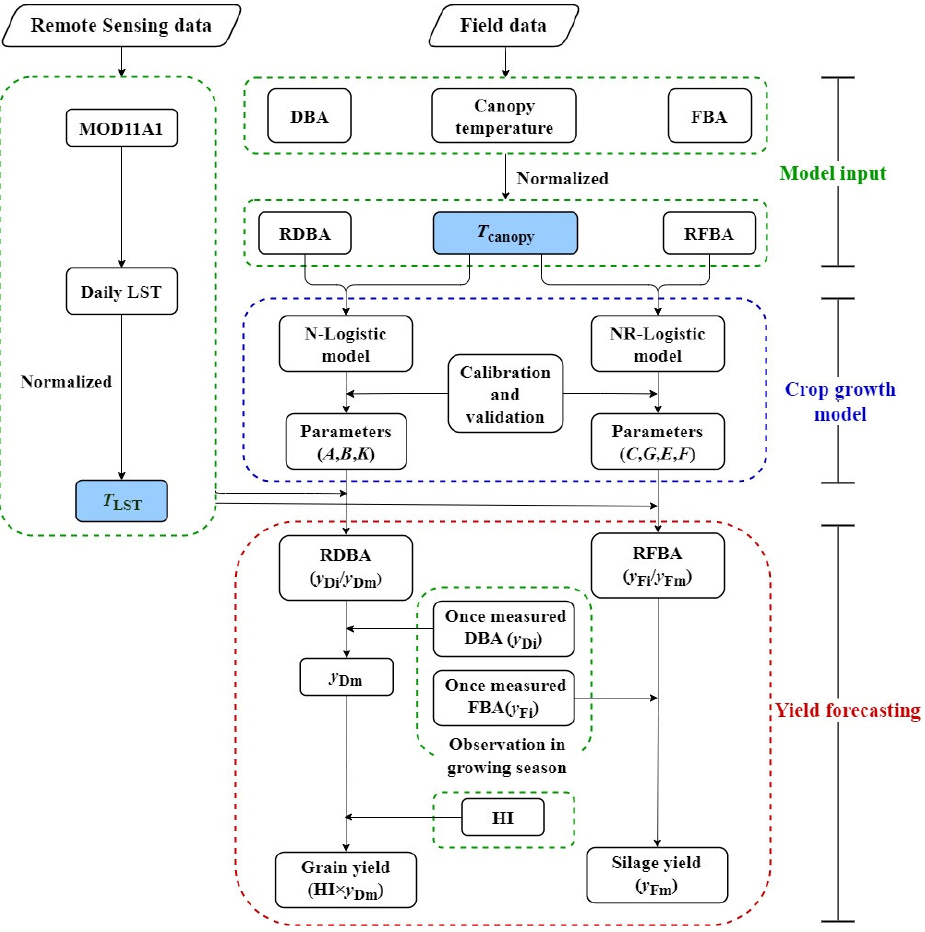
Figure 4. Schematic of the approach for yield forecasting using crop canopy temperature. Notes: DBA is dry biomass accumulation, kg ha − 1 ; FBA is fresh biomass accumulation, kg ha − 1 ; RDBA is relative DBA; RFBA is relative FBA; T canopy represents relative effective accumulated temperature in canopy; LST is land surface temperature, ◦ C; T LST represents relative effective accumulative temperature calculated by LST; y Di is DBA in the maize growing season, kg ha − 1 ; y Dm is DBA at harvest, kg ha − 1 ; y Fi is the above-ground FBA in the maize growing season, kg ha − 1 ; y Fm represents the maximum FBA, kg ha −1 ; HI is harvest index.